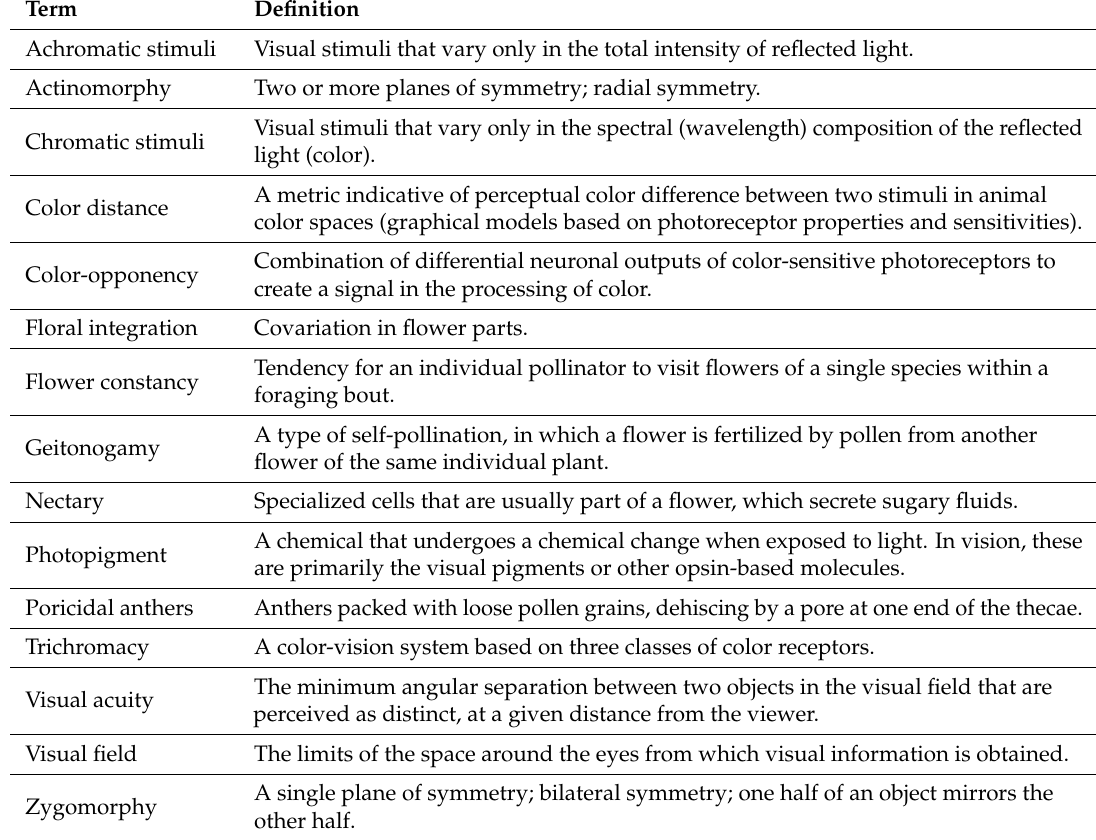
Table 1. Glossary of terms used in this